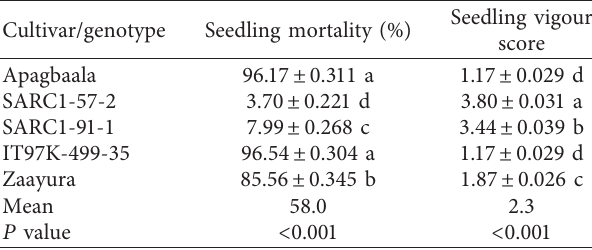
Table 3: Effect of aphid infestation on mean seedling mortality and vigour of cowpea